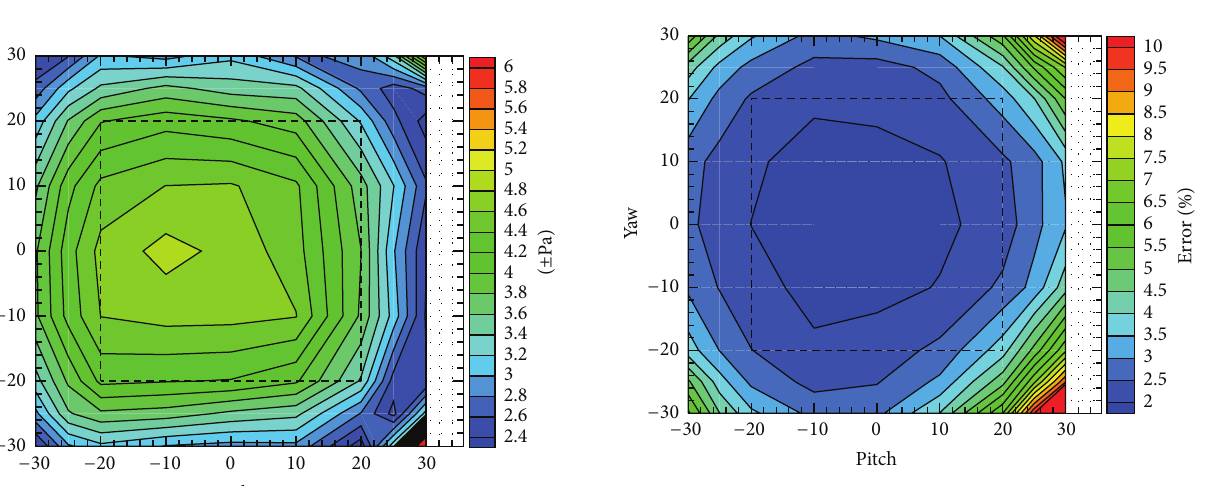
Figure 11: Total pressure uncertainty at 20m/s, 81 (9 × 9) points (in terms of ± Pa).